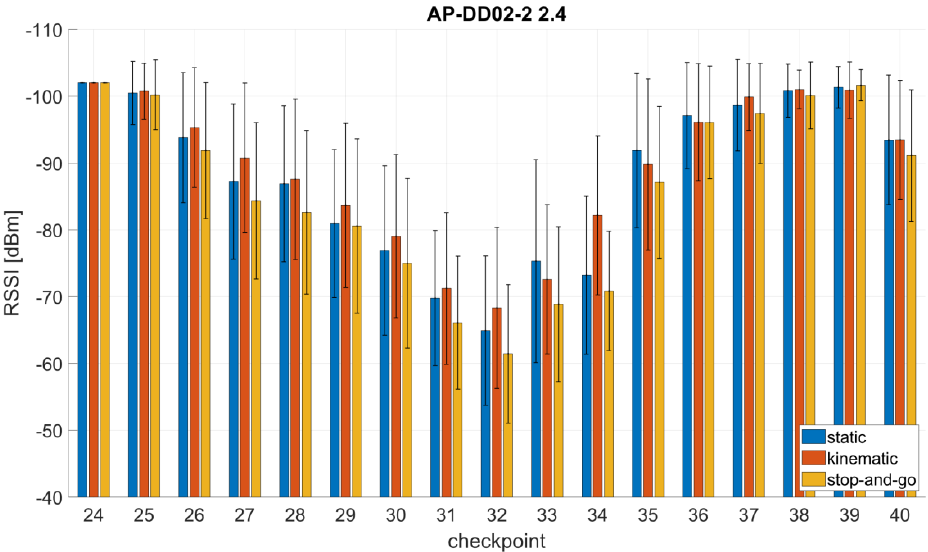
Figure 6. Mean RSSI and their standard deviations for comparison of the databases of the three measurement modes static, kinematic and stop-and-go. Table 5. Mean correlation coefficients and variances for the comparison of the different fingerprint databases.